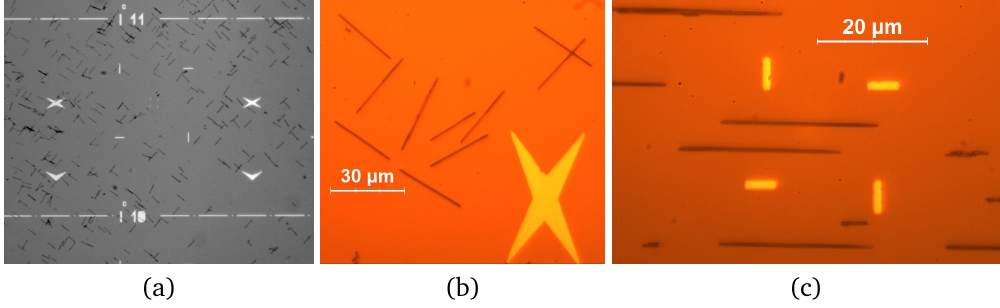
Fig. 6: Optical images of magnetic CoNiB tubes dispersed on Si substrates with Au alignment marks . (a) overview of a substrate with two orthogonal sets of tubes, (b) detail of another area (rotated by 90 ◦ ). (c) Another sample, now with all tubes aligned along the same direction. Alignment of the tubes is promoted by a permanent magnet placed below the substrate during the dispersion of tubes from a